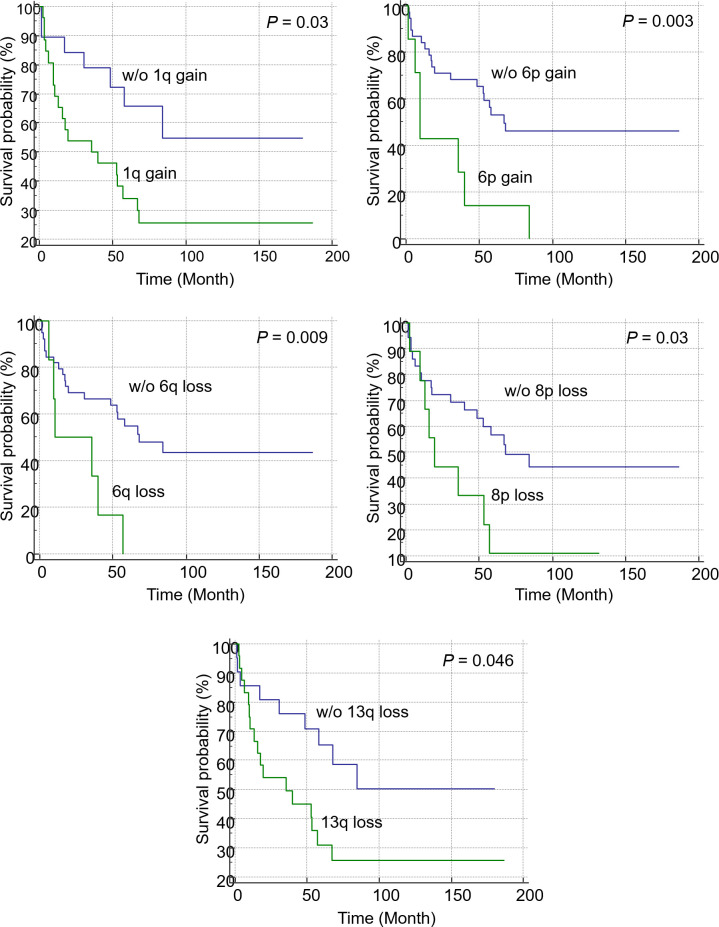
Kaplan-Meier analysis of overall survival in patients with copy number variations.Patients with 1q gain (P = 0.03), 6p gain (P = 0.003), 6q loss (P = 0.009), 8p loss (P = 0.03), and 13q loss (P = 0.046) were significantly correlated with poor prognosis in the log-rank test.